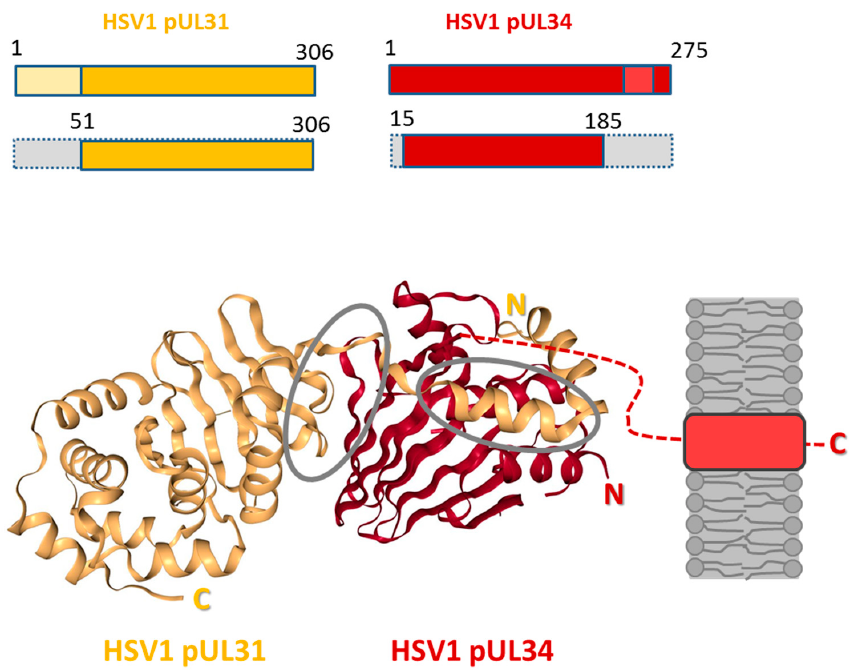
Figure 4. Structure of the HSV1 nuclear egress complex. The structure of the HSV1 pUL31-pUL34 complex is shown as cartoon representation (source: [42] ). HSV1 pUL34 and pUL31 and the truncated versions used for the crystals presented are graphically depicted [38] . pUL31 is shown in orange, and pUL34 is shown in red. Interfaces are circled in grey. The inner nuclear membrane (grey) and the tail-anchor domain of pUL34 (light red) are schematically depicted; N: N-terminus; C: C-terminus.